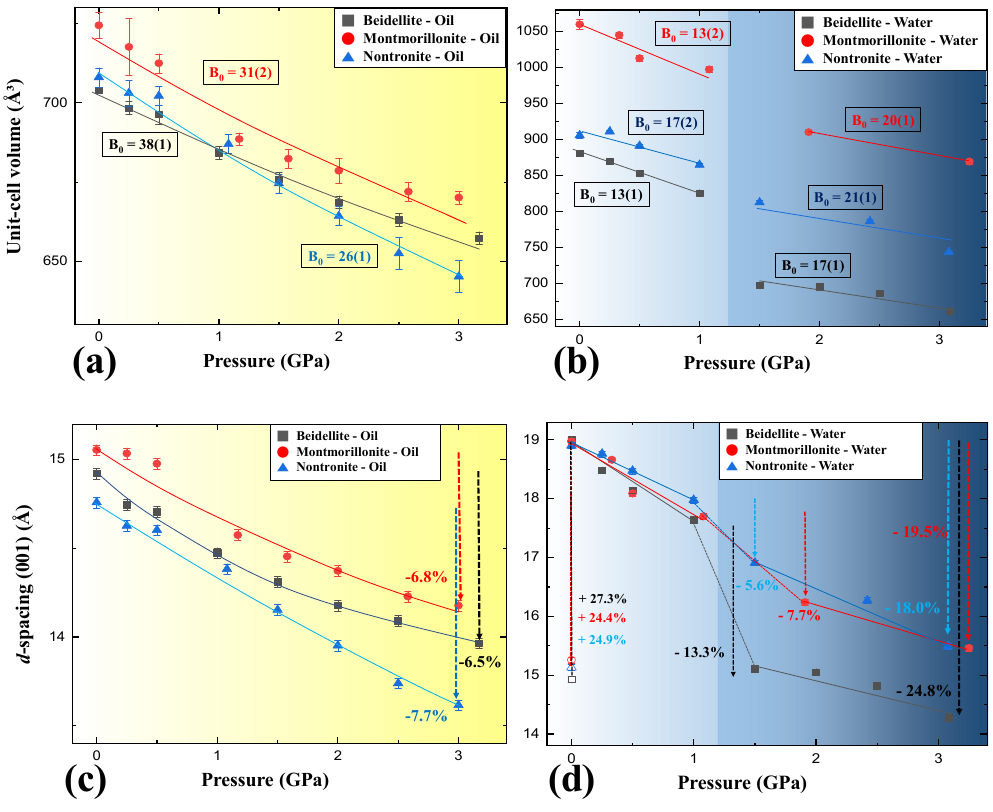
Table 1. Bulk moduli of beidellite, montmorillonite, and nontronite under silicone oil and distilled water PTMs (ESD’s (estimated standard deviations) are in parentheses). Figure 4. Comparative bulk-moduli of smectite under ( a ) silicone oil and ( b ) distilled water PTMs conditions at room temperature. Pressure-dependent interplane (001) distance changes of smectite under ( c ) silicone oil and ( d ) distilled water PTM conditions. The dashed arrows show percent changes.